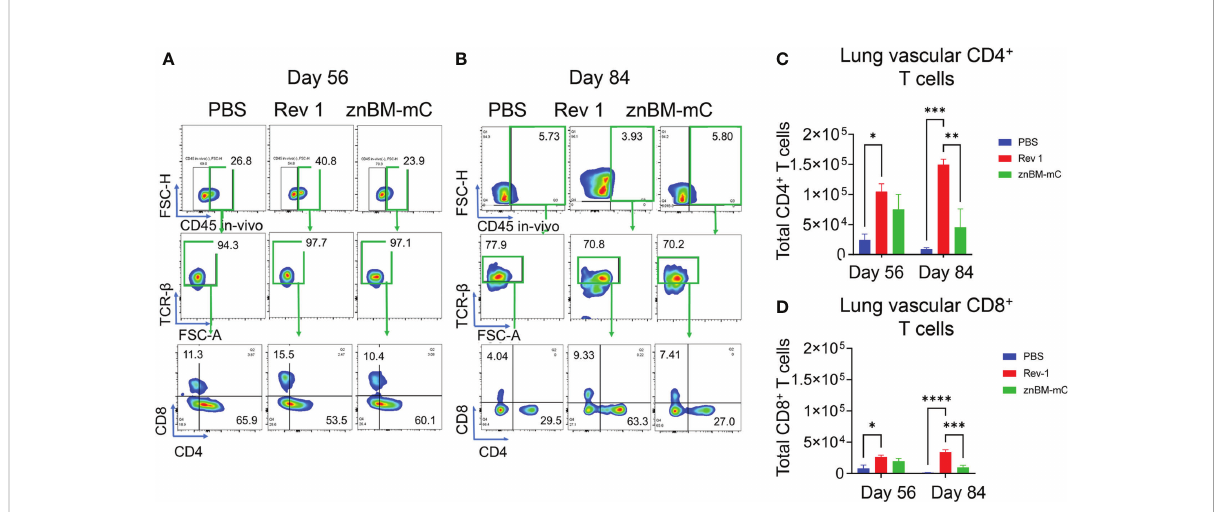
FIGURE 4 Mucosal vaccination with znBM-mC increases vascular lung CD4 + T cells. Groups of mice (the same as described in Figure 3) were vaccinated with sPBS, Rev 1, or znBM-mC and then subjected to pulmonary challenge with 5 × 10 4 CFUs wt B. melitensis 16M. Circulating lymphocytes were identi fi ed by in vivo IV labeling with an anti-CD45 mAb as per Figure 3. Flow cytometric analysis of isolated lung lymphocytes shows the circulating lymphocyte population identi fi ed as IV CD45 + cells on (A) day 56 and (B) day 84, gated as TCR b + cells, and then gated as CD4 + and CD8 + T-cell subsets. The total numbers of circulating lung (C) CD4 + and (D) CD8 + T cells on days 56 and 84 are depicted. Data are representative of three independent experiments with n ≥ 5 mice/group. Differences within T-cell subsets compared to PBS-dosed mice of that subset are shown: *p <0.05; **p <0.005, ***p <0.0005, and ****p <0.0001 using two-way analysis of variance performed followed by Tukey ’ s multiple comparisons test.